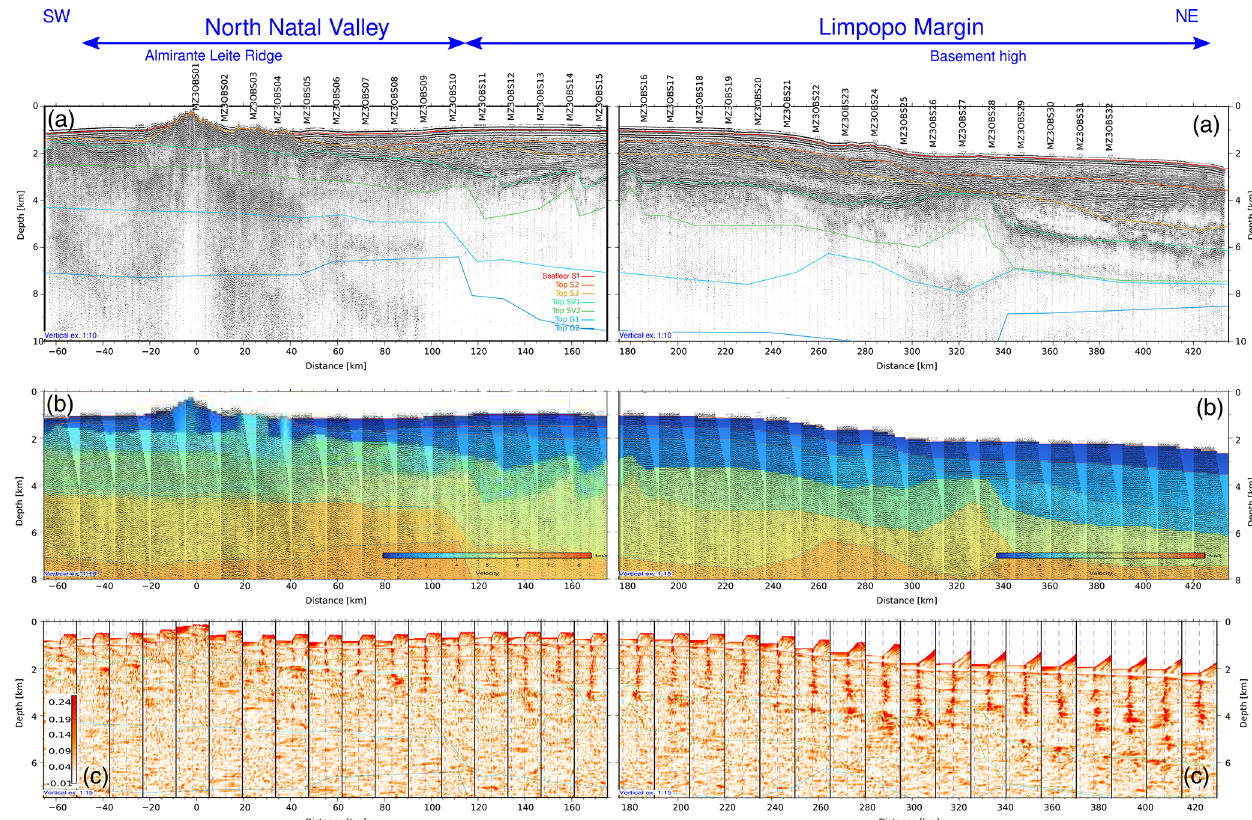
Figure C1. Pre-stack depth migration of MCS MZ3 profile. The left column shows the SW portion, and the right column shows the NE portion. (a) PSDM record section. The intersections with the MOZ35 dataset are indicated by a red line. Vertical exaggeration is 1 : 10. (b) Residual moveout. (c) Semblance plot of the RMO. Common image gathers are spaced every 7.5km. Vertical exaggeration is 1 : 15. Model interfaces are represented with continuous